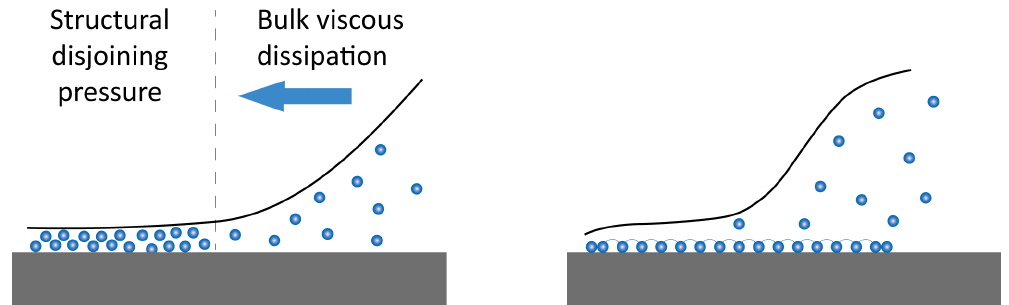
Figure 8. Schemes of the nanoparticle ordering in the wedge of a spreading meniscus ( left ), and the lubrication effect provoked by nanoparticle adsorption onto the solid ( right ). Figure adapted from Ref.